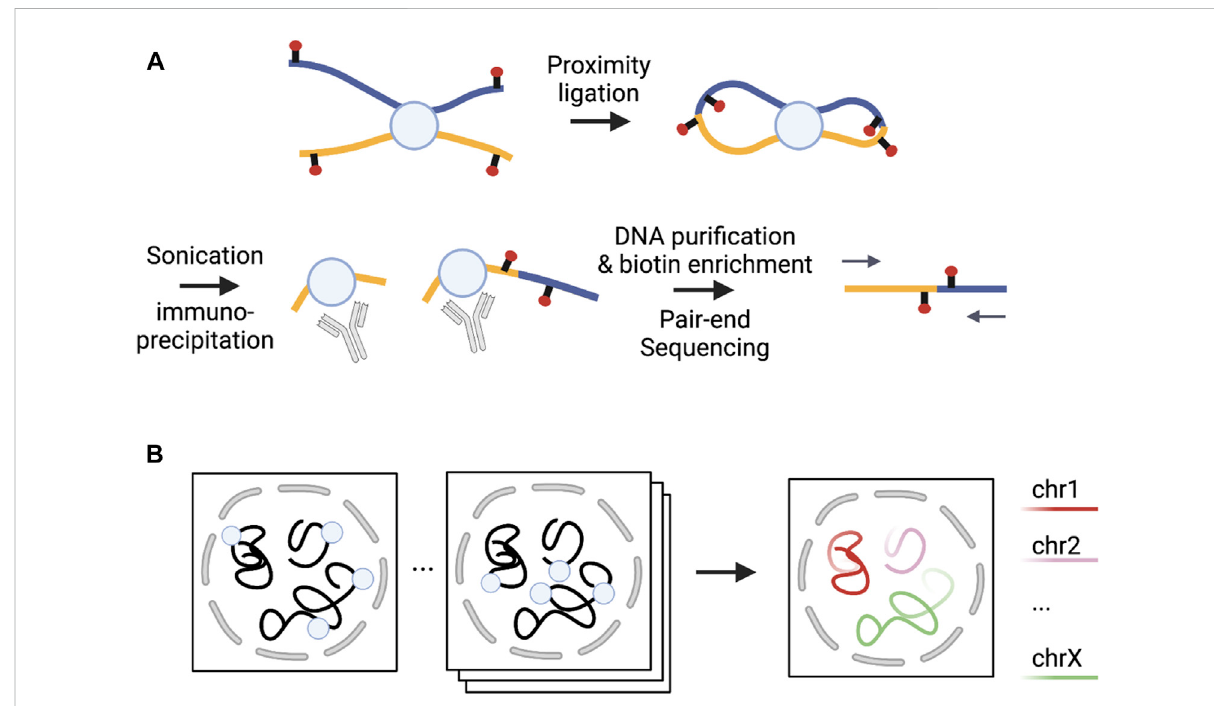
FIGURE 1 Illustrations of sequencing- and microscopy-based methods. (A) [Adapted from Figure 1A in (Fang et al., 2016)] Sequencing-based PLAC-seq method captures chromatin interactions mediated by a protein of interest; (B) [Adapted from Figure 1A in (Su et al., 2020)] Microscopy-based DNA MERFISH method allows multiplexed genome-scale imaging. Each square on the left of the arrow represents one round of imaging where each circle represents one locus imaged. In each round, multiple loci are simultaneously imaged. After many rounds of imaging, genome-scale imaging can be obtained. Note that the number of rounds required to image the same number of loci is inversely proportional to the number of loci imaged simultaneously, withsubstantiallyreducednumberofrounds compared to thesequencingimaging strategy where onlyonelocus isimaged in each